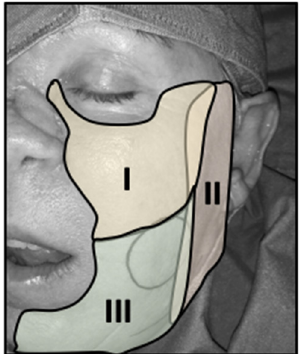
Figure 1. Aesthetic zones of the cheek. The cheek can be divided into three partially, overlapping aesthetic zones, comprising the suborbital ( I ), the preauricular ( II ), and the bucco-mandibular ( III ) zone [9]. The circle already marks the margins for planed tumor resection of a squamous cell carcinoma that is mainly located in zone III.